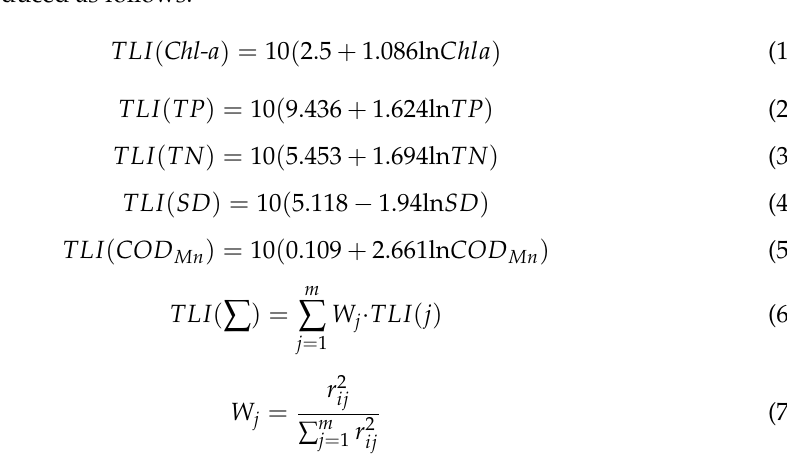
values between some parameters and Chl-a in Chinese lakes. ij